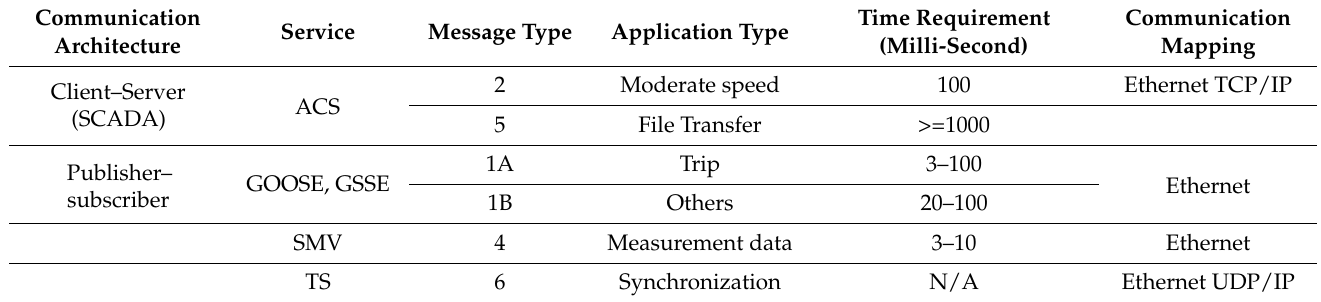
Table 1. Transmission protocols for IEC